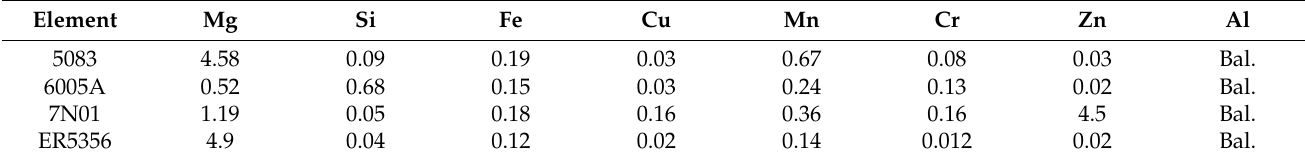
Table 1. The chemical composition of 5083, 6005A, 7N01 Al alloy and ER5356 (wt.%).